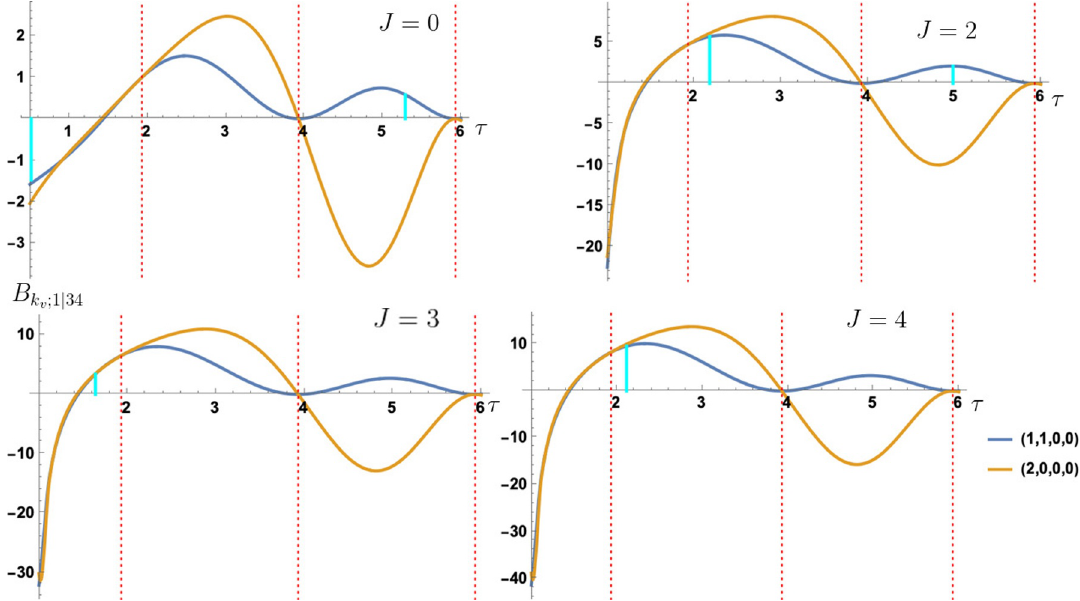
for the h (cid:15)σ(cid:15)σ i acting on conformal blocks G of different spin J , Figure 9 . Action of B ∆ ,J k ;1 | 34 twist τ = ∆ − J and subtraction schemes k = (1 , 1 , 0 , 0) and (2 , 0 , 0 , 0) represented as blue and orange curves respectively. Red dotted vertical lines denote double-twist values while vertical cyan lines denote the Ising model operators appearing in the OPE of h (cid:15)σ(cid:15)σ i .